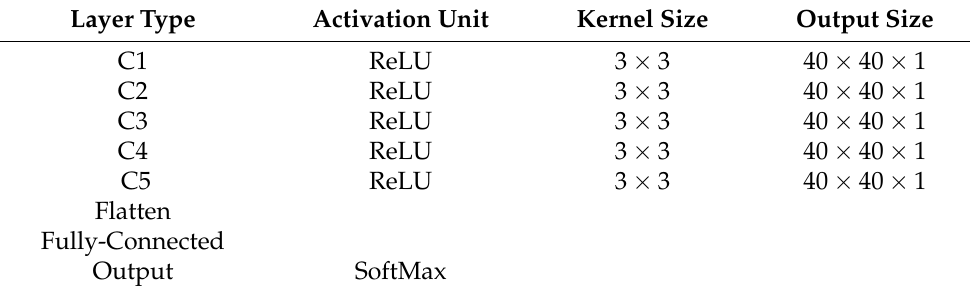
Table 1. Parameters of the CNN architecture used in this